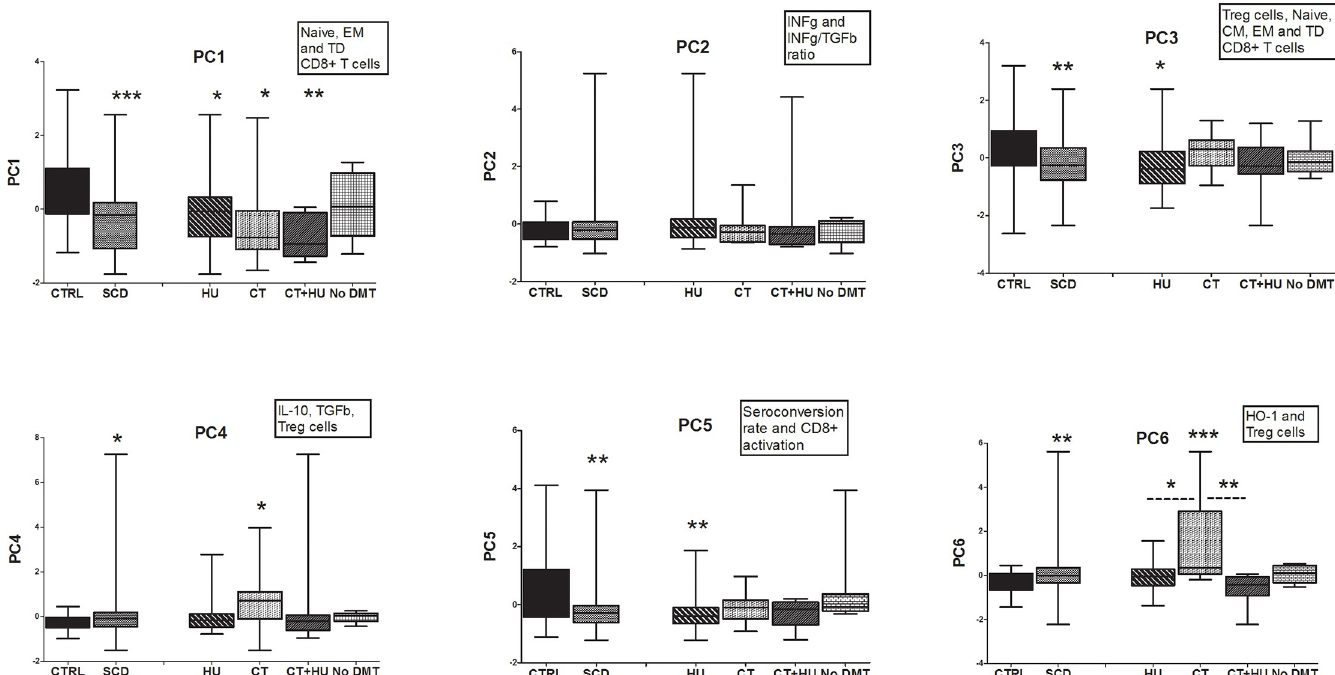
Fig 5. Principal component analysis. Box plots of PC1 to PC6 for SCD treatment groups compared to healthy controls. Comparison between groups was assessed by Kruskal-Wallis analysis of variance, followed by a Dunn’s multiple. The nonparametric Mann-Whitney U test was used for the comparison of SCD patients and healthy